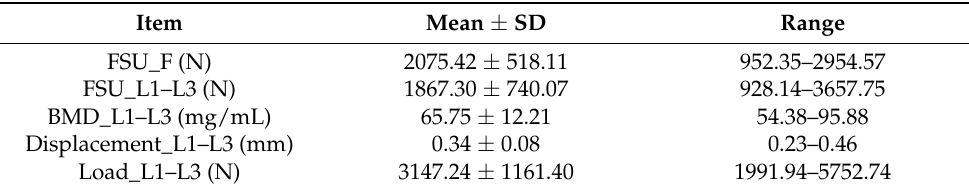
Table 2. Results of finite element analysis (FEA) and volumetric bone mineral density (vBMD) mea-